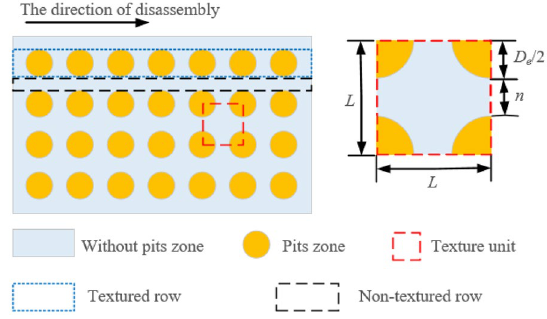
Figure 7 Diagram of textured surface and texture unit (Taking the circular texture as an